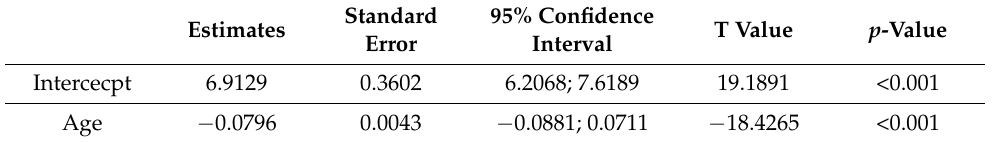
Table 3. Estimated mixed linear model on the logarithmically transformed LTL (table of fixed